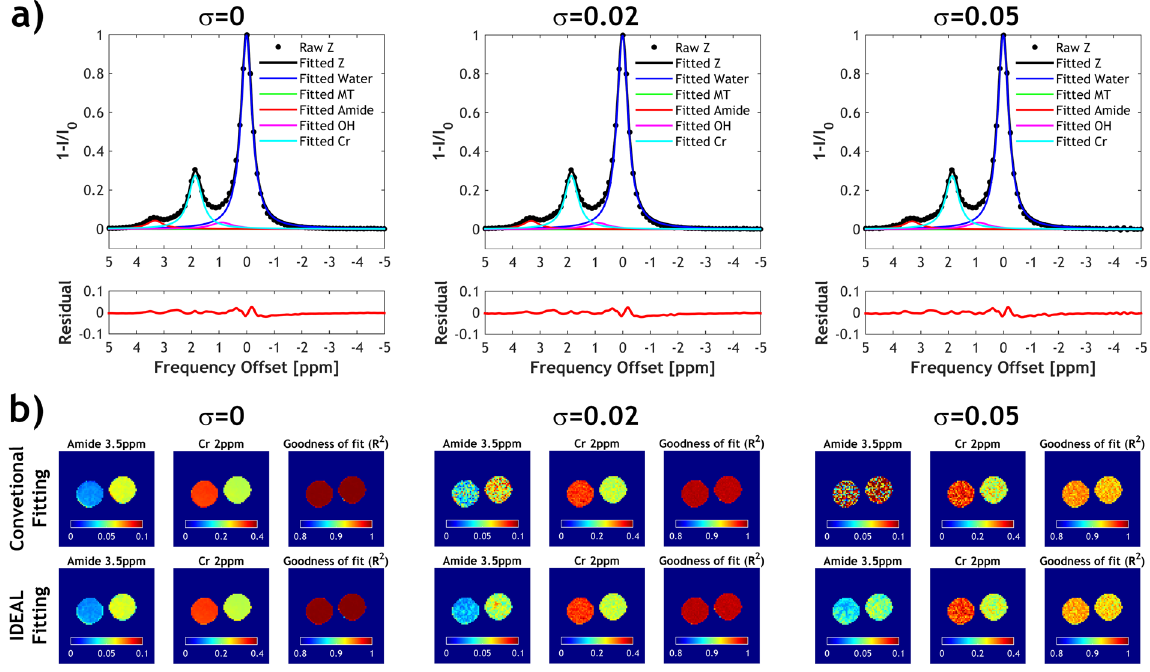
Figure 2. Conventional voxel-wise multi-pool Lorentzian fitting versus Image Downsampling Expedited Adaptive Least-squares (IDEAL) fitting in the two-compartment phantom (left: 50 mM Creatine (Cr) and 100 mM nicotinamide (amide); right: 100 mM Cr and 50 mM amide) with different levels of Gaussian noise added. ( a ) Multi-pool Lorentzian fit of the global Z spectra at different noise levels to determine initial values for IDEAL fitting. The global Z spectrum was obtained by averaging the Z spectra of all voxels within the phantom. ( b ) Fitted amide and Cr maps using conventional fitting or IDEAL fitting. The corresponding R 2 maps were